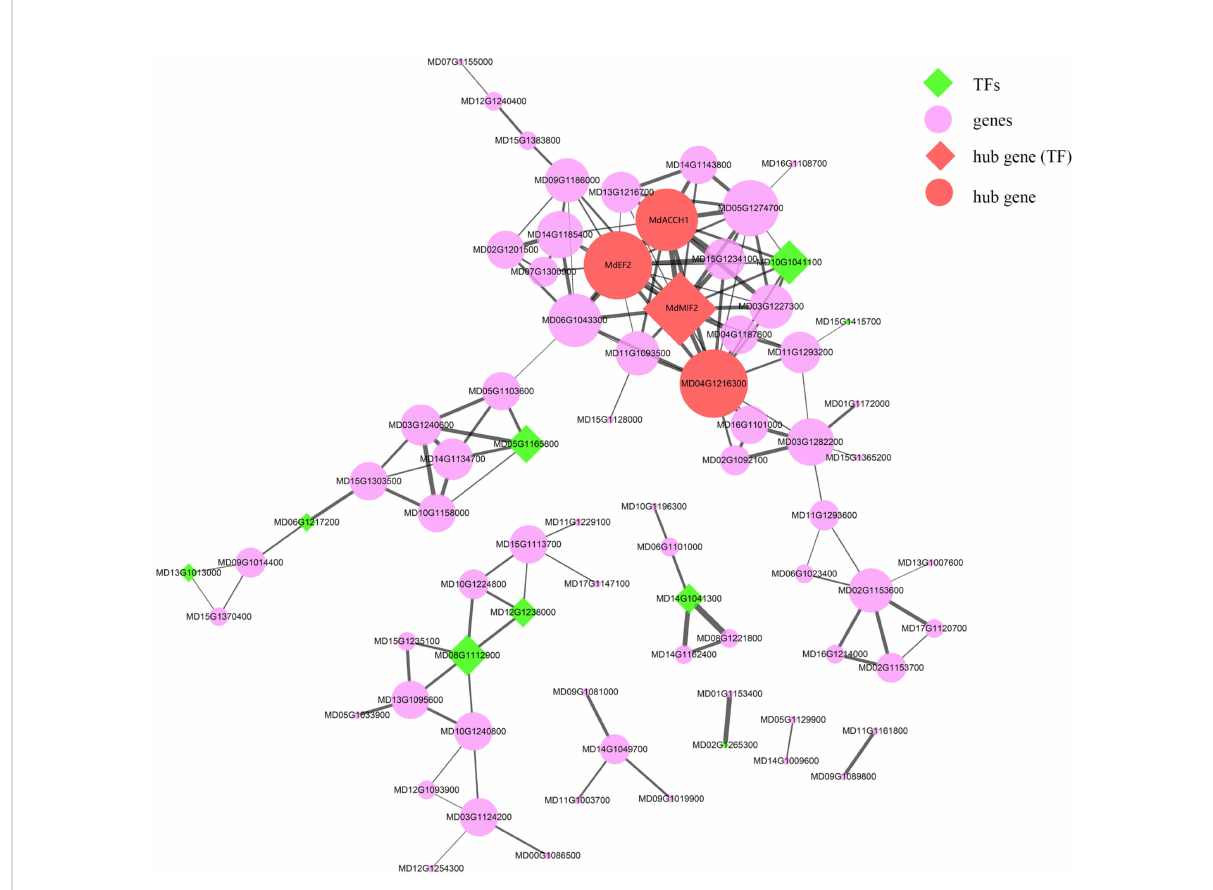
FIGURE 6 The co-expression network of the “ MEpurple ” module. The green diamonds indicate transcription factors (TFs) and the red diamonds indicate the hub genes, which are also TFs. The purple and red fi lled circles denote the genes and hub genes in this module, respectively. The width of edges corresponds to the weight value between different genes, with a larger width being indicative of a larger